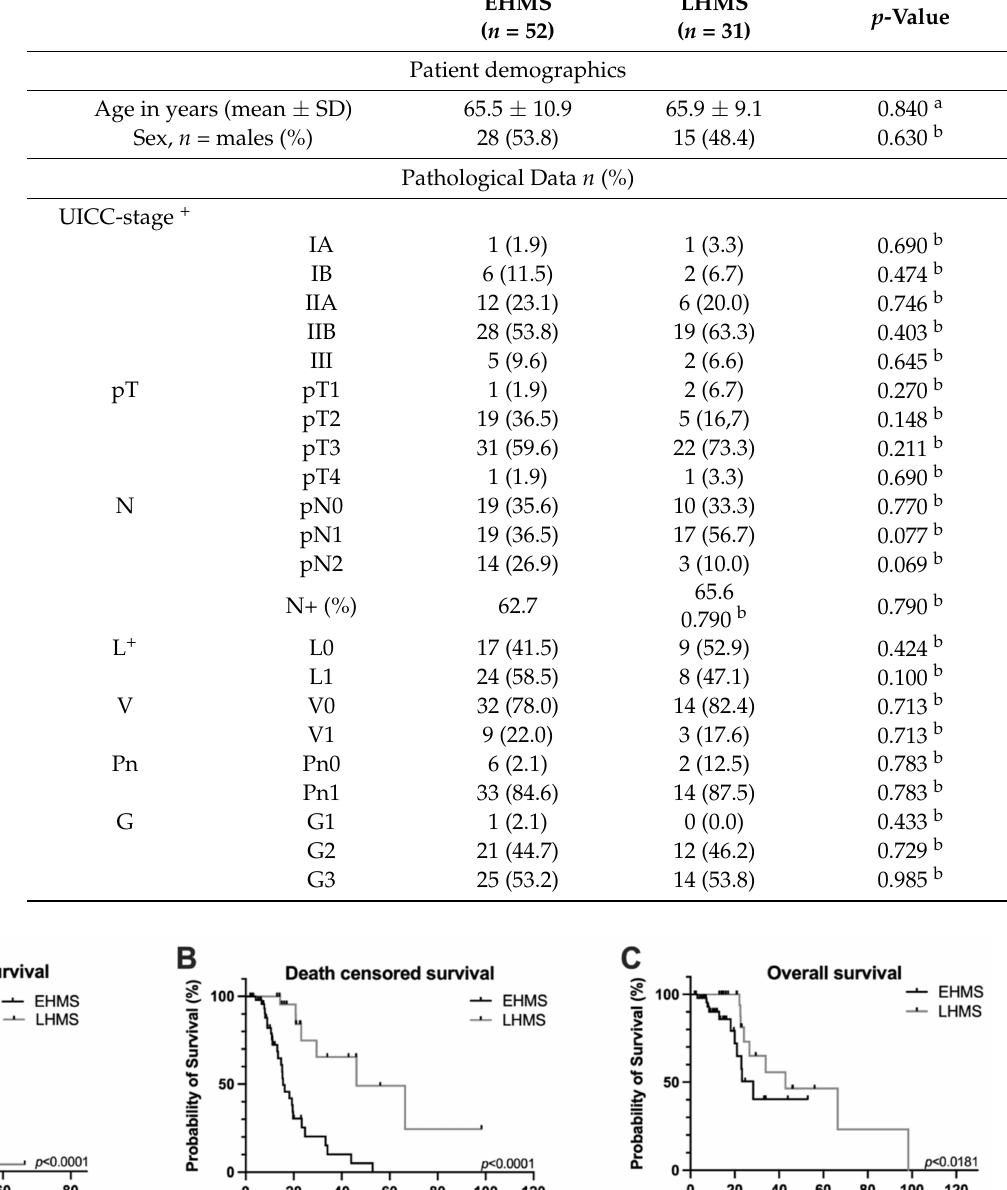
Table 1. Demographic and pathological data of PDAC patients included stratified by early ( ≤ 12 months, n = 52) and late (>12 months, n = 31) metastatic hepatic spread (EHMS and LHMS). Data are presented as mean ± SD, total numbers ( n ) or relative frequencies (%). Continuous variables were tested using a Students’ t -test (normally distributed), while categorical variables were compared using b Chi-Square. EHMS: early hepatic metastatic spread; G: Grade; L: Lymphatic infiltration;